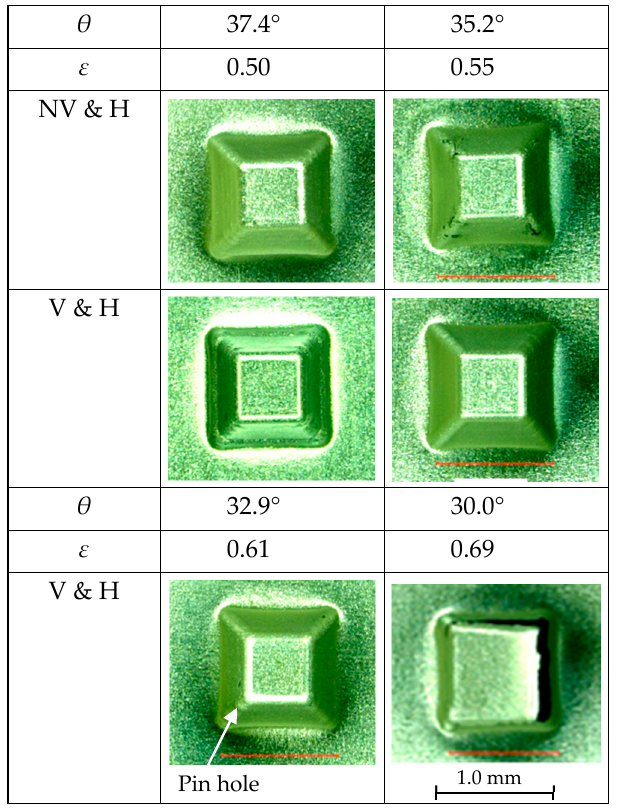
Figure 7. Forming limits for truncated pyramids with and without ultrasonic vibration (V and NV) and with laser heating